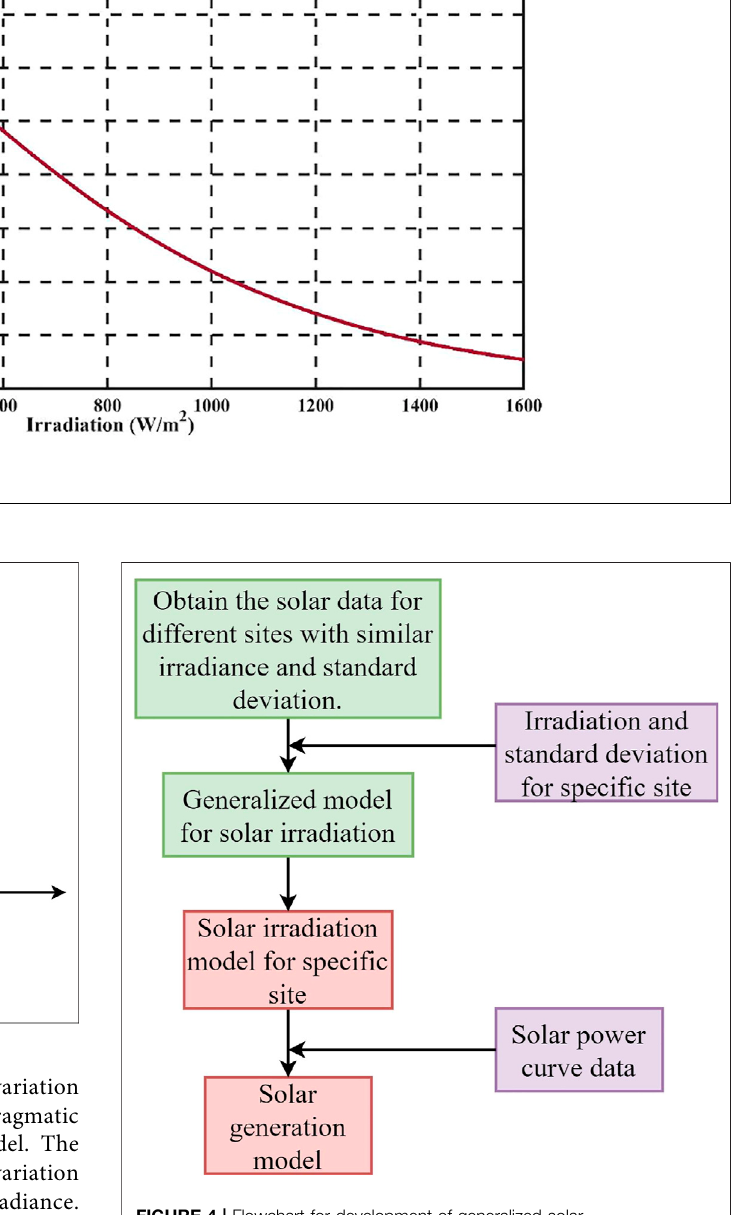
FIGURE 4 | Flowchart for development of generalized solar irradiation